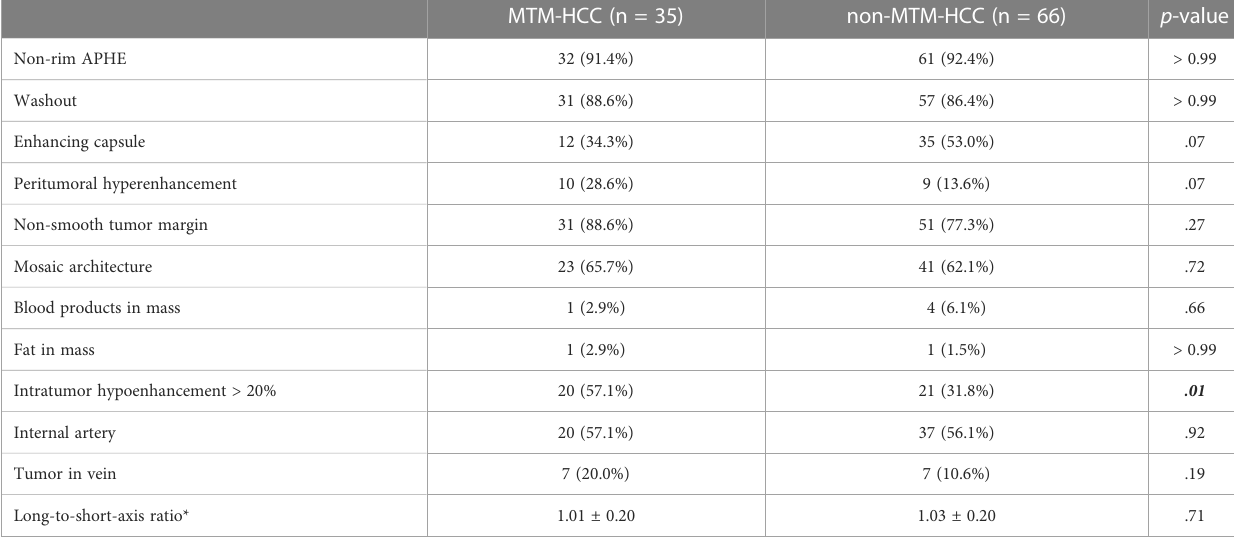
TABLE 3 Comparison of the CT imaging features of MTM-HCCs and